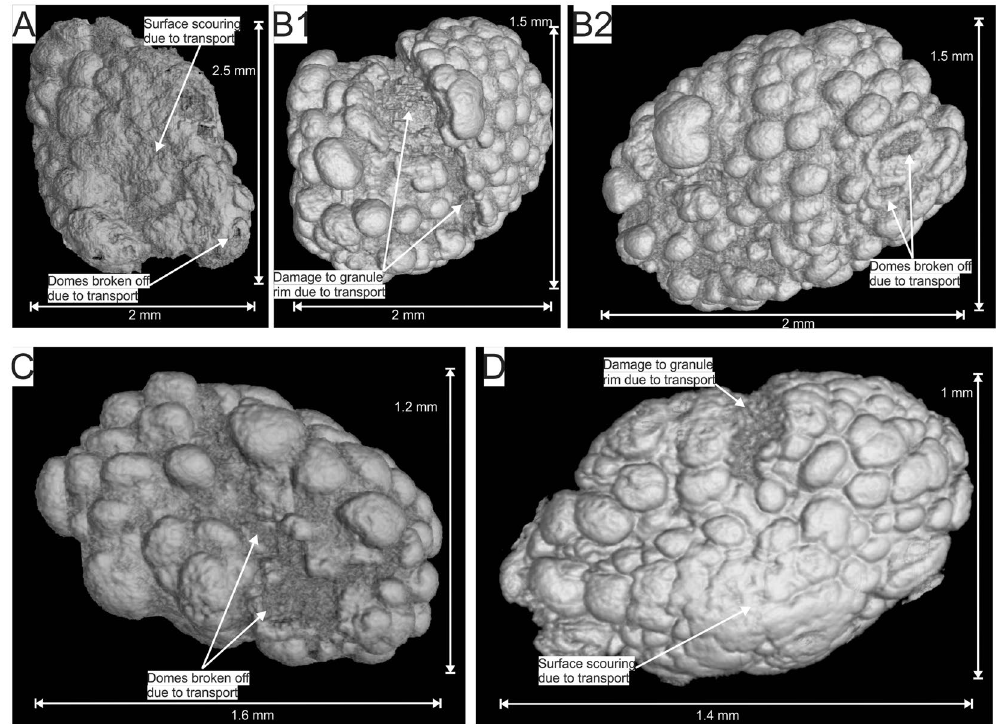
Figure 4. False colour three dimensional reconstructions of µ XCT scans of the same four magnetite coated granules granules from Fig. 2 from drill core samples of the Nconga Formation GIF illustrating different alterations to the outer surface of the granules and the domical structures (see text for more detail). See the following supplementary videos for full rotational animations of the extracted granules: 6 for granule A; 8 for granule B; 10 for granule C; 11 for granule D. The images were created using VGStudio Max version 3.2 (https://www.volumegraphics.com/en/products/vgstudio-max.html) and the final figure was compiled using CorelDRAW 2017